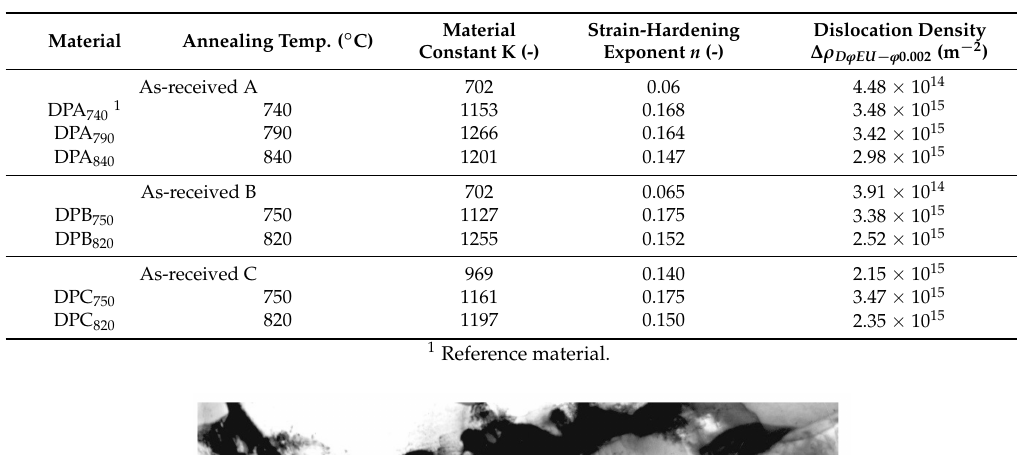
Table 4. The calculated values of material constant K, the strain-hardening exponent n , and the dislocation density.